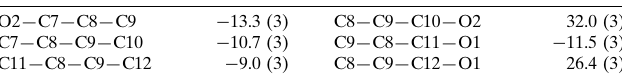
Selected torsion angles ( (cid:2) ).